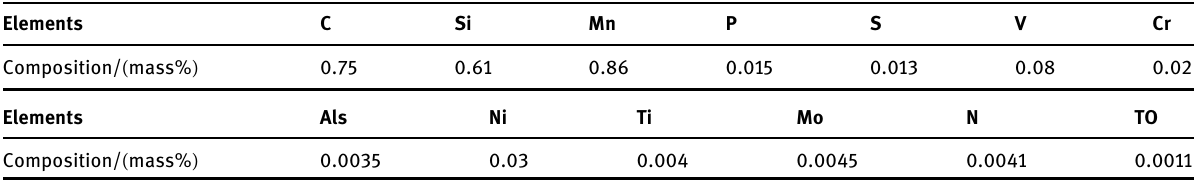
Elements C Composition/ ( mass%